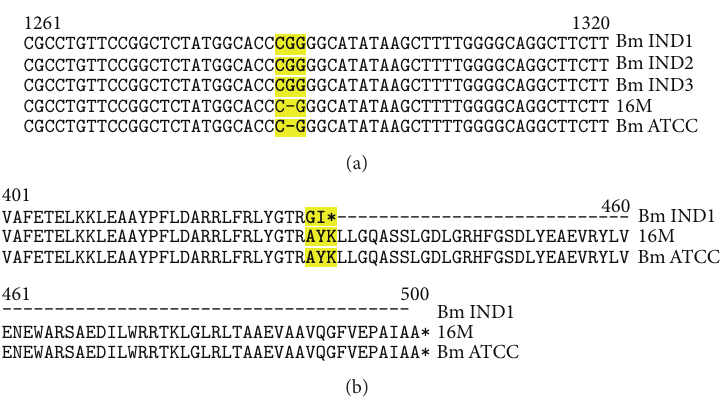
Figure 8: Sequence alignment of 3 terminus regions of glpD gene. (a) Insertion of “G” in the glpD gene (position 1286) of Bm IND strains in comparison to B . melitensis 16M (16M) and B . melitensis ATCC23457 (Bm ATCC). (b) Deletion of 69 nucleotides from the C-terminus of glpD of Bm IND1 as a result of the nucleotide insertion.